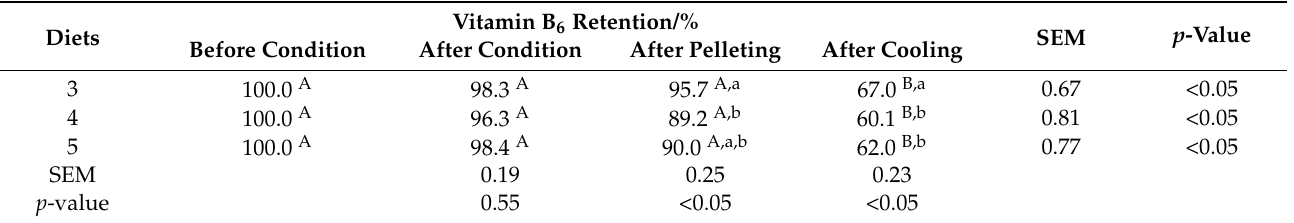
Table 7. The retention of vitamin B 6 in diets during pelleting and the long-term high-temperature stabilization